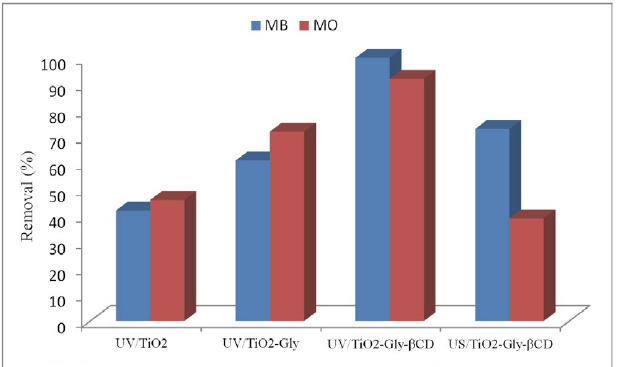
Fig. 6. Effect of contact time on the sonocatalytic degradation of dyes (C ppm, Catalyst dose = 0.01 g/l, T = 298 K).